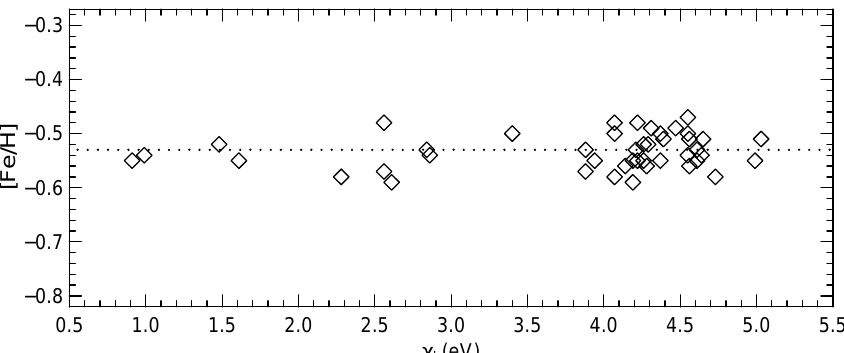
Fig. 1. The [Fe i /H] abundance values versus the lower excitation potential (cid:31) exc for (cid:21) And. The mean abundance ([Fe i /H]= (cid:0) 0 : 53 dex) is shown by a dotted line.